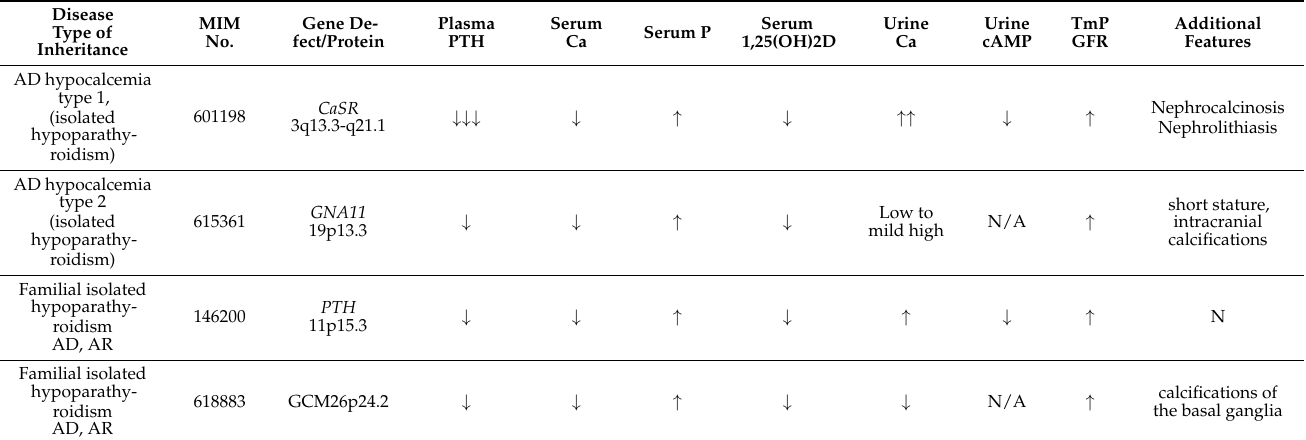
Table 3. Hypoparathyroidism genetic